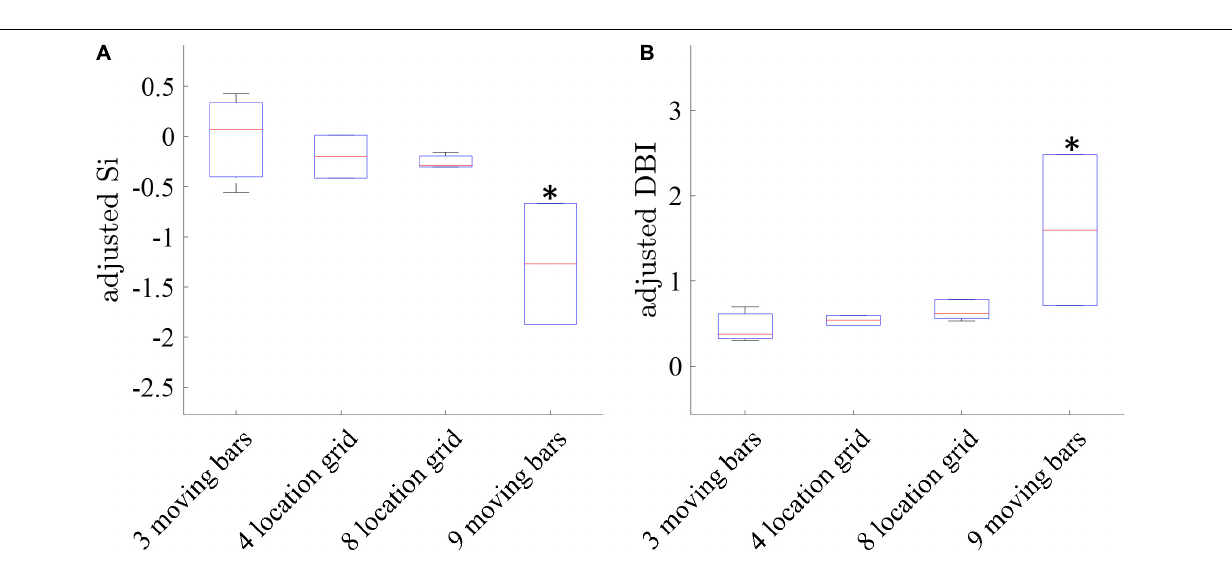
FIGURE 9 | Comparison of the clustering separation metrics in the 3, 4 and 8-location grid and the more challenging 9-moving bars. Retinotopic maps in this comparison were performed by the combined GLM and TSCA analysis method. (A) The median Silhouette Index of the maps (B) The Davies-Bouldin Index of the maps. ∗ Significantly different than the 3 moving bars, 4 grid, and 8 grid stimulations ( p <